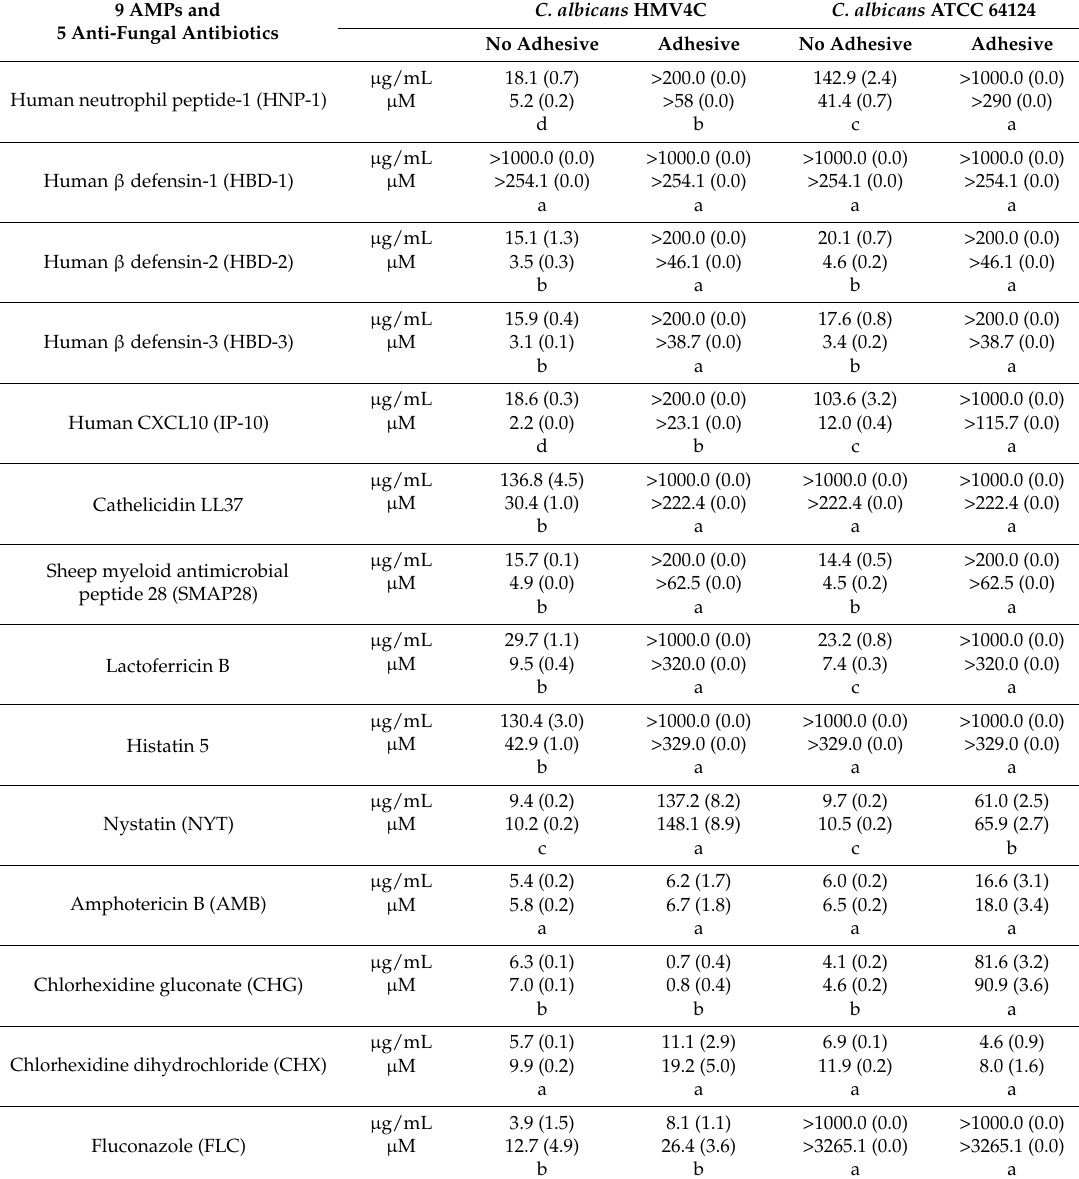
Table 1. Minimal inhibitory concentrations (MICs) of AMPs and antifungal antibiotics against C. albicans . Mean (standard error, n = 3) values. The µ M values in each row with the same letter are not significantly different ( p <